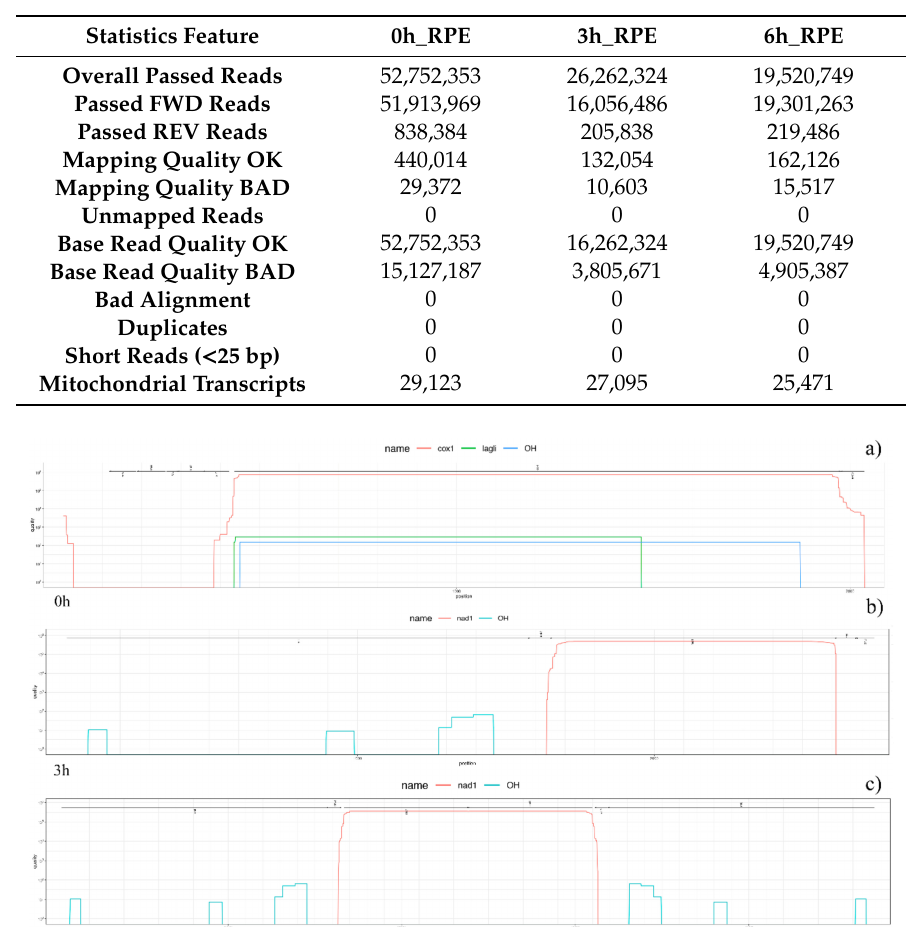
Figure 4. Protein coding gene plots. Figure shows annotated protein coding genes after congruences detection from BLASTX. The protein plot highlights the quality value (on a log scale) for each gene and each position if it is above the threshold. Di ff erent genes are evidenced by distinctive colors, with the initial hits corresponding to the represented “mountains”. The lines shown on the top represent the reported annotation. Annotation of protein coding genes reached the best results in untreated sample ( a ) while, in both time-related treated samples, the only protein coding gene identified with high quality was NAD1 ( b , c